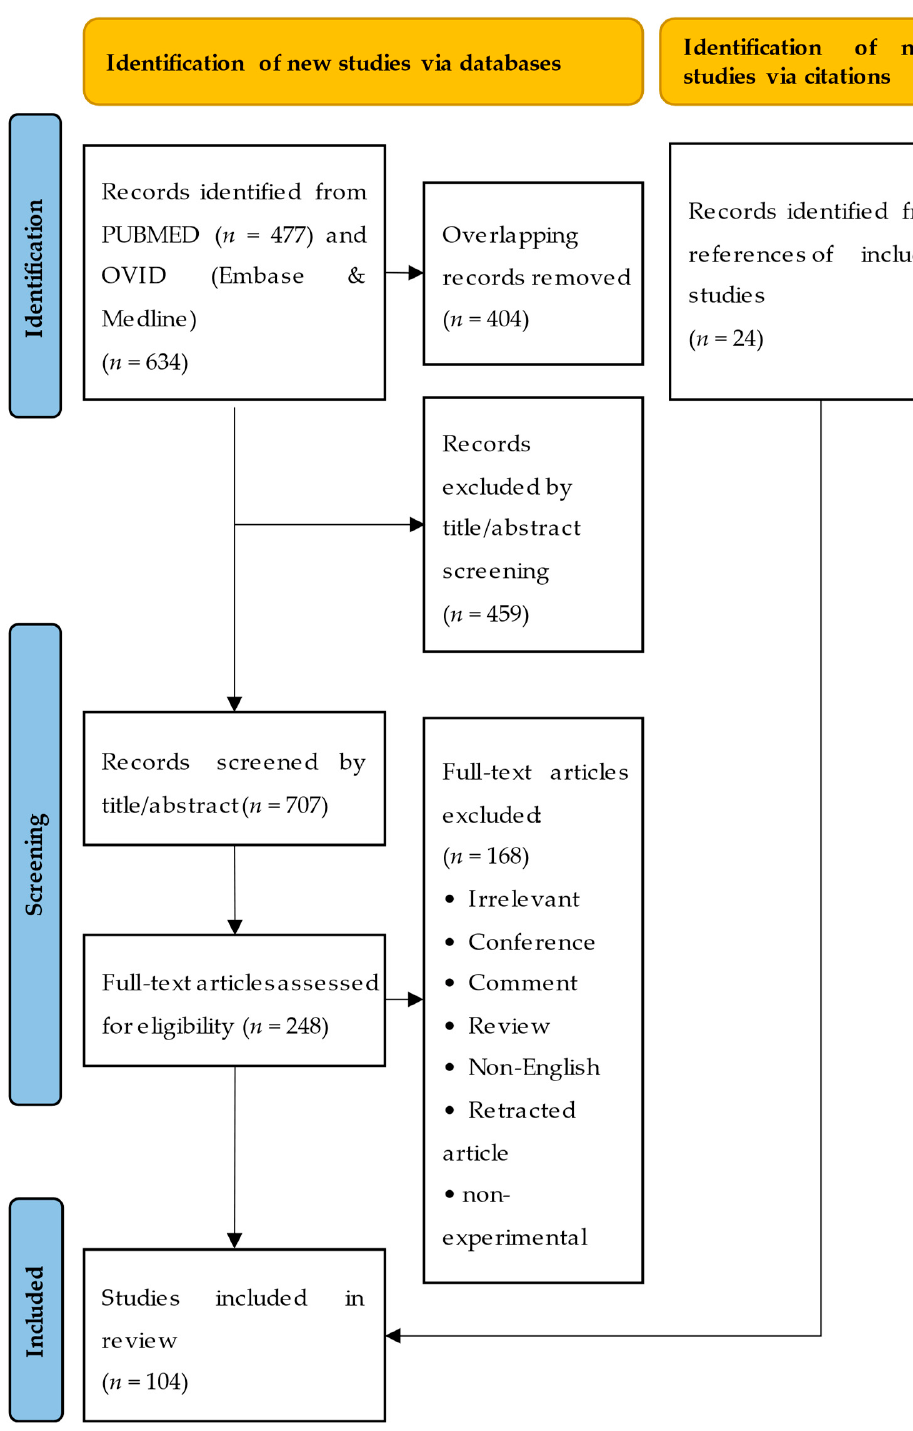
Figure 1. PRISMA flow diagram. Presentation of the procedure of literature searching and selection with numbers of articles at each stage.